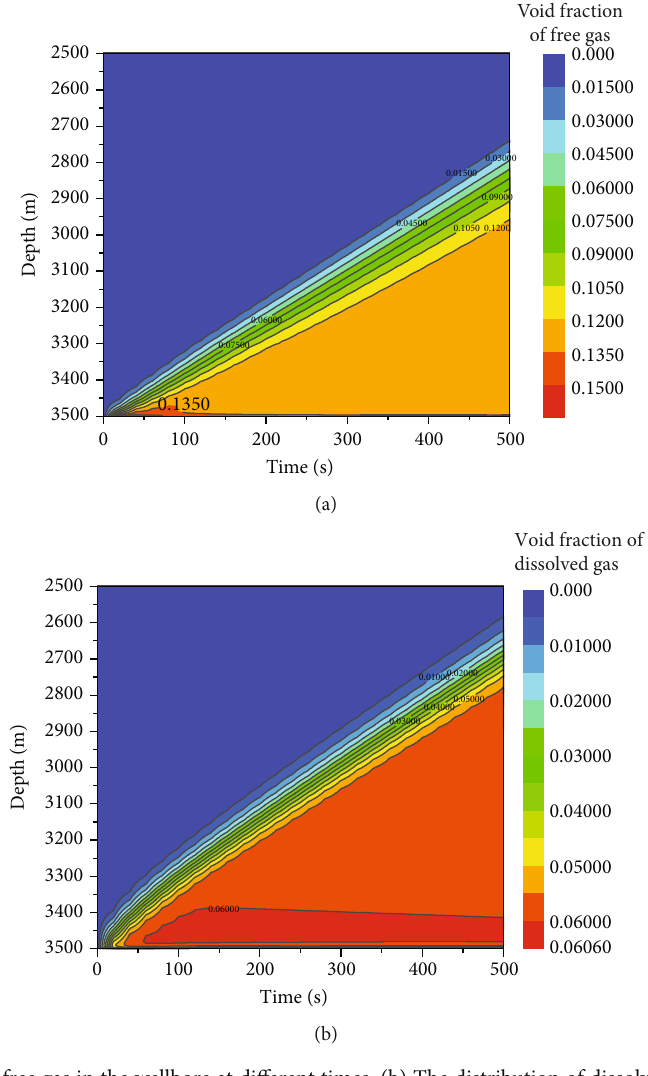
Figure 4: (a) The distribution of free gas in the wellbore at di ff erent times. (b) The distribution of dissolved gas in the wellbore at di ff erent